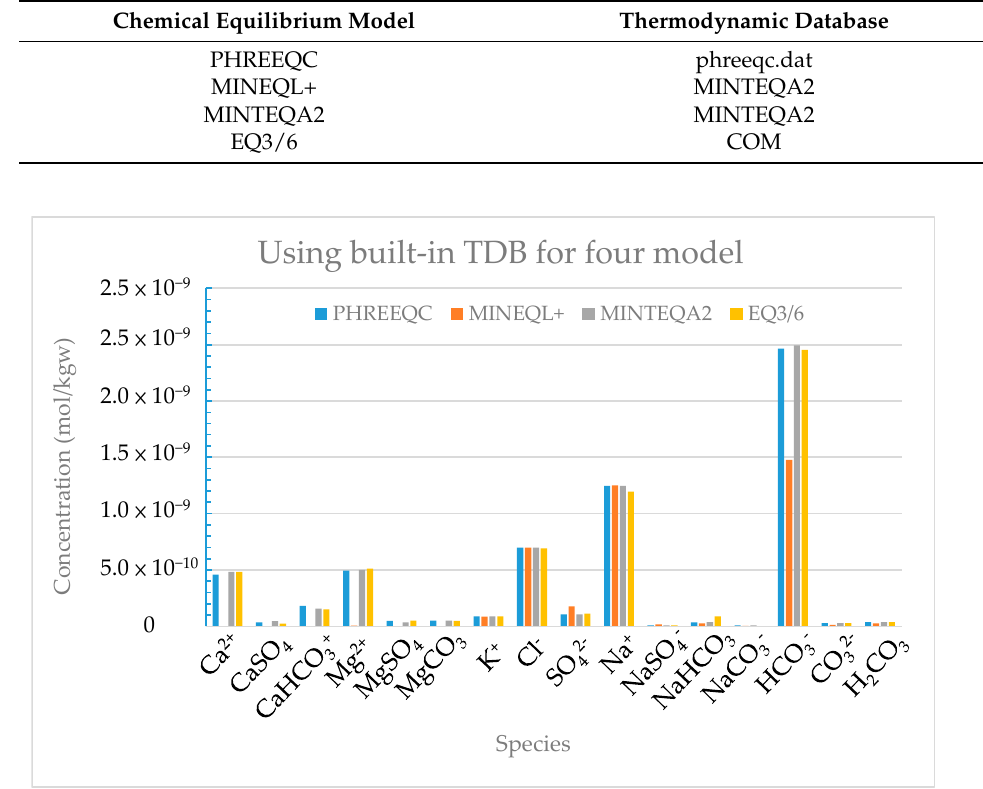
Table 9. Thermodynamic databases used by the four chemical equilibrium models.